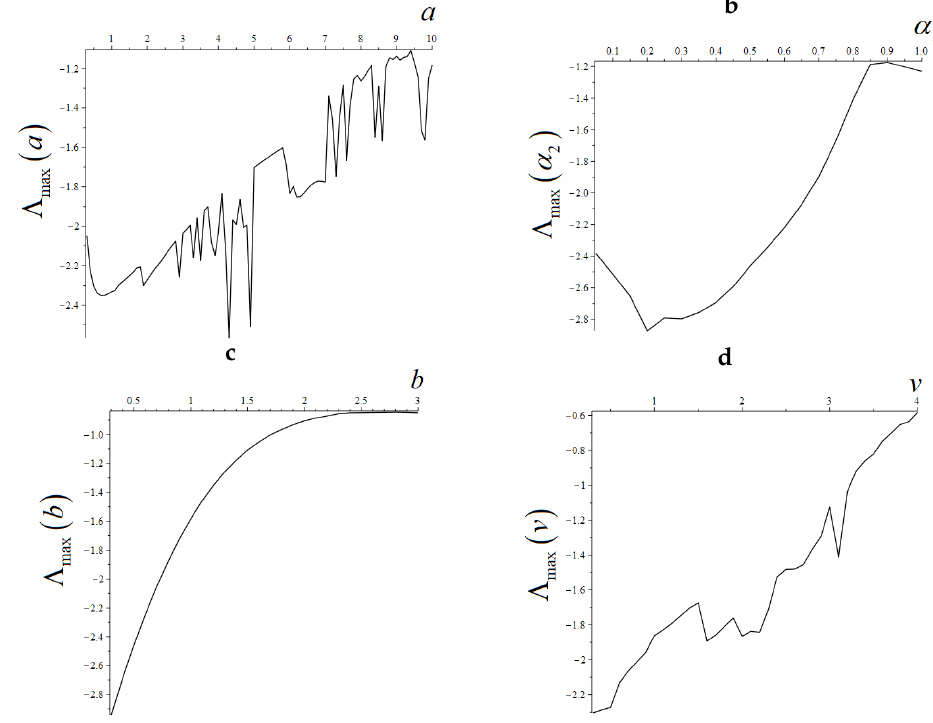
Figure 6. Spectra MLE: ( a )— Λ max ( a ) ; ( b )— Λ max ( α 2 ) ; ( c )— Λ max ( b ) ; ( d )— Λ max ( v )